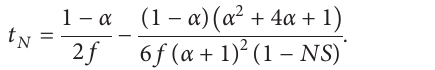
Figure 4: Velocity curve for mold oscillation.